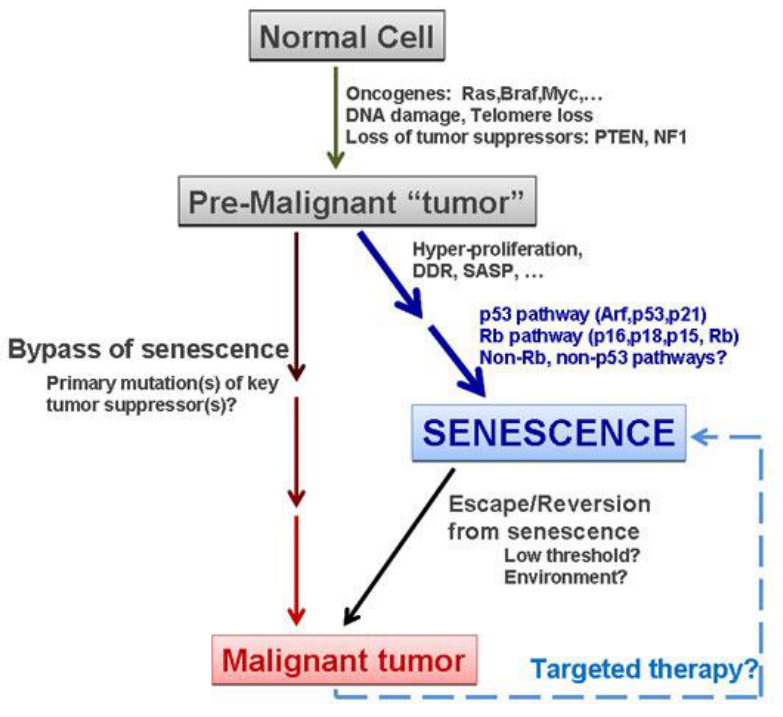
FIGURE 1. Premalignant lesions may progress to cancer by either bypass of senescence through disruption of signals responsible for senescence induction or they may escape from an established senescent state by disrupting signals responsible for maintenance of senescence. Identification of key signaling pathways may allow targeted therapy to re-establish senescence in malignant